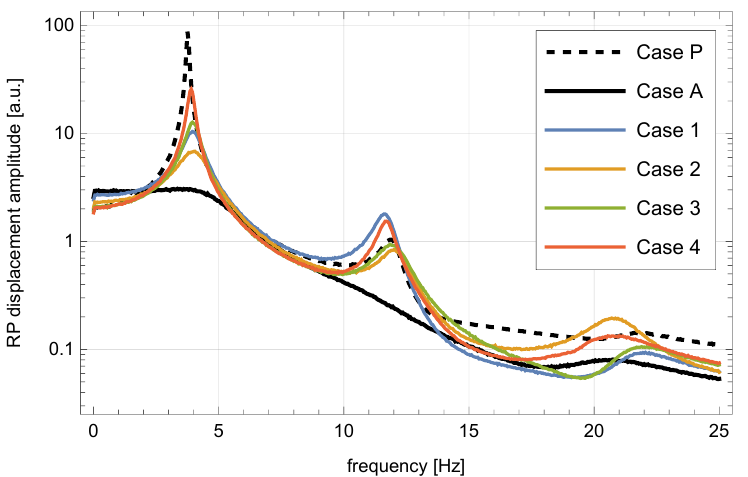
Figure 8. Frequency-domain amplitudes of the RP displacement responses in all considered control cases (in arbitrary units,